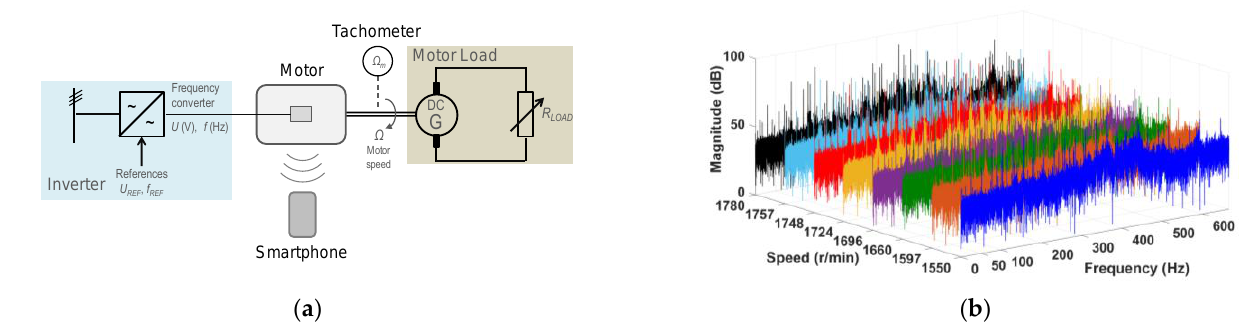
Figure 9. DC generator coupled to the motor shaft: ( a ) the test configuration; ( b ) the spectra of the motor noise signals.